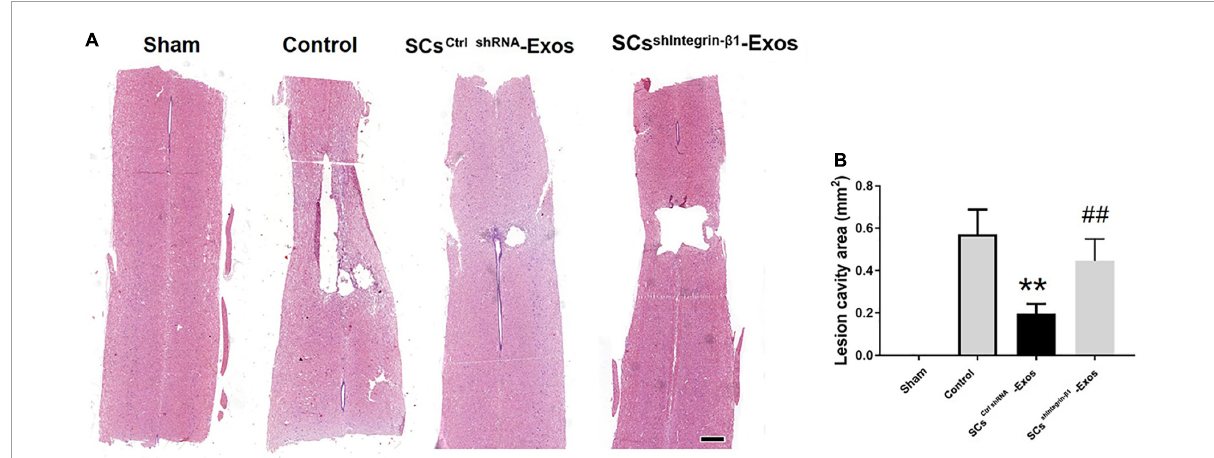
FIGURE7 Exosomal Integrin- β 1 of SCs-Exos attenuates tissue damage after SCI. (A) Representative H&E staining of lesion cavity of the spinal cord in each group. (B) Quantification of lesion cavity of each group. The data are presented as mean ± SD. ** p < 0.01 Control group vs. SCs ctrlshRNA -Exos group, ## p < 0.01 SCs ctrlshRNA -Exos group vs. SCs shIntegrin − β 1 -Exos group. N = 5 in each group. Scale bar = 1 mm.